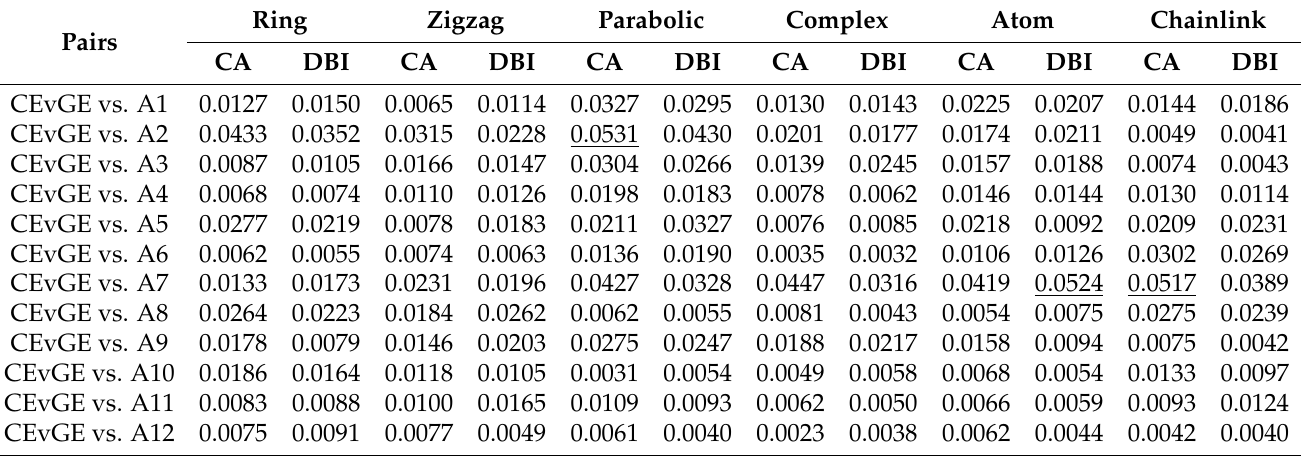
Table 7. The p -values of Student’s t -test of CEvGE vs. contrastive algorithms on synthetic data sets ( p > 0.05 are underlined).